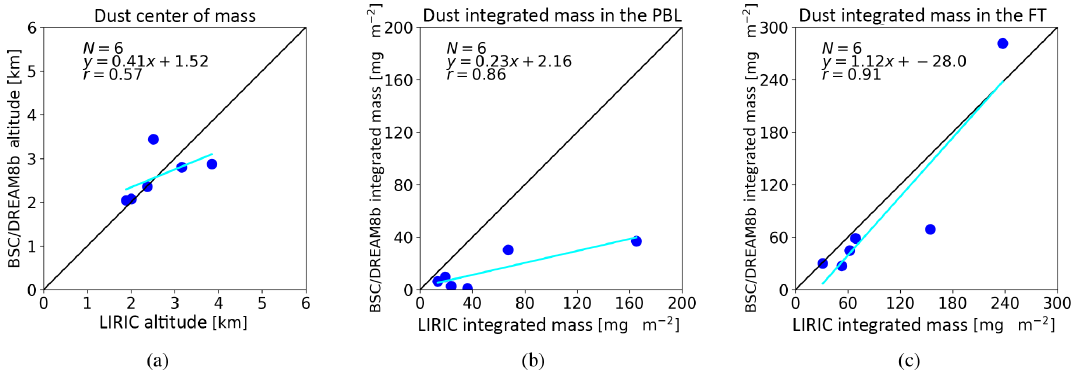
Figure 8. (a) Scatterplots of the center of mass of the dust cases for BSC-DREAM8b. (b) Scatterplots of the integrated mass of the dust cases for BSC-DREAM8b in the boundary layer. (c) Scatterplots of the integrated mass of the dust cases for BSC-DREAM8b in the free troposphere. The least square fit line is also included. The correlation coefficient for those cases is provided as well. The figure corresponds to the dust cases of the period 2013–2015. Table 5. Dust center of mass metrics. Metrics for the two models and LIRIC are provided. A total of 6 out of 22 cases are included in the category “dust”. Differences in the LIRIC values per model are attributed to the interpolation in different vertical resolution depending on the model. The mean, standard deviation, mean bias and root mean square error values are in km units. Pearson’s correlation coefficient ( r ) and the least square fit slope (a) and intercept (b) values are also calculated.